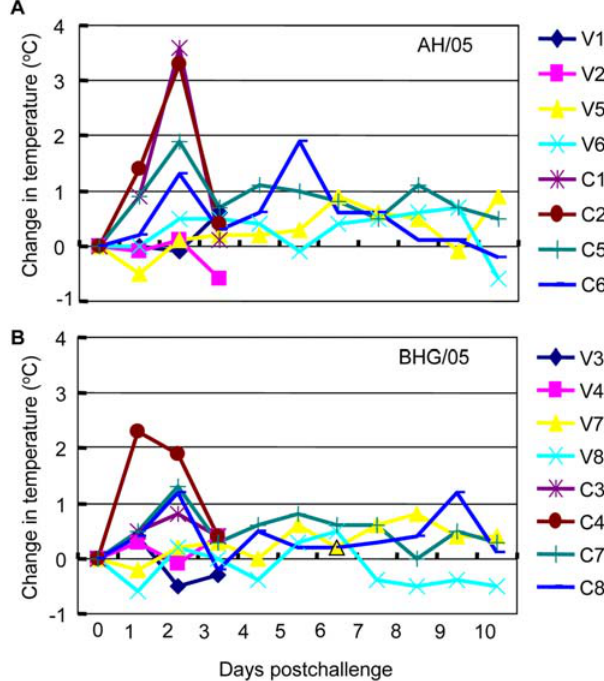
Figure 4. Body temperature of nonhuman primates after challenge with AH/05 virus. Change in body temperature in nonhuman primates after challenge with AH/05 virus (A) or BHG/05 virus (B). Changes were calculated by subtracting the mean temper- ature 3 days before challenge from the temperature recorded on the indicated